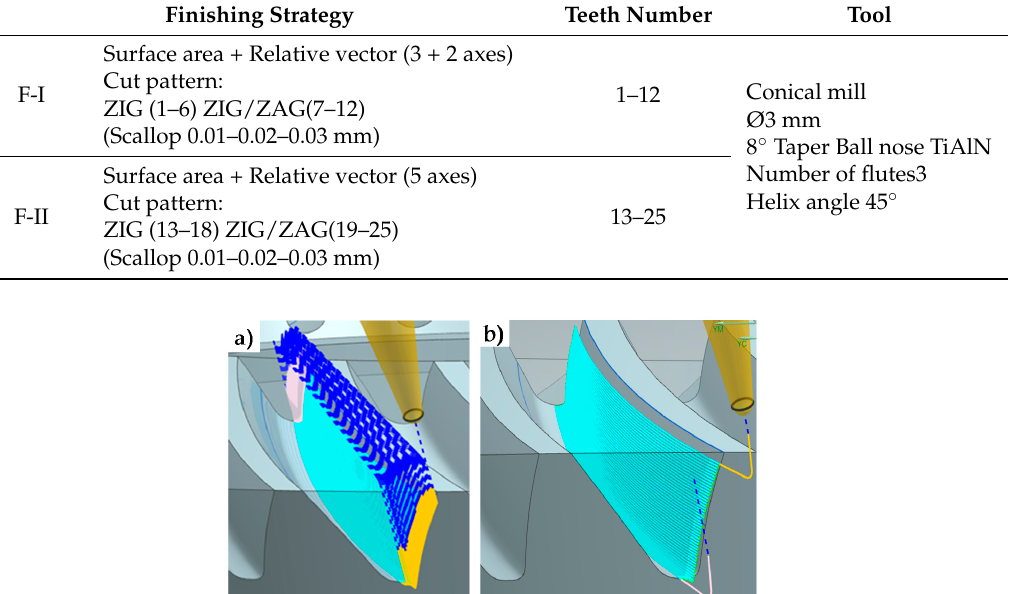
Figure 3. Finishing strategies. F-I ( a ) 3 + 2 finishing strategy. F-II ( b ) 5 continuous axes finishing strategy.